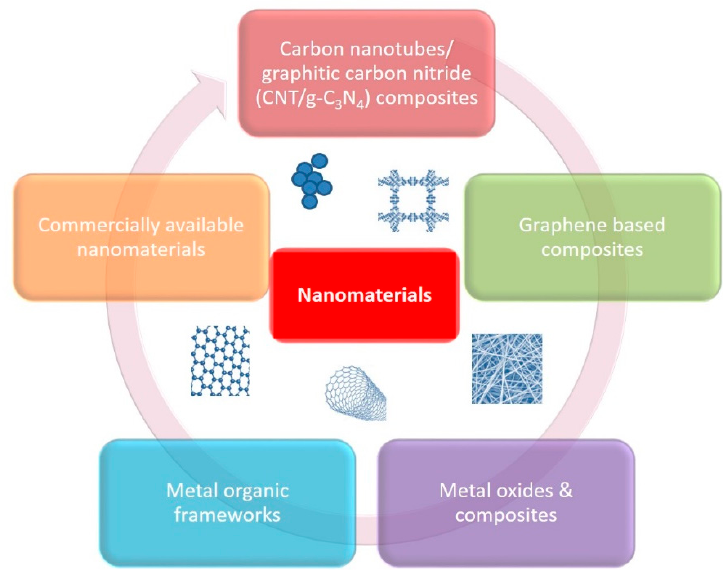
Figure 1. Different categories of nanomaterials presented in the present review (carbon nanotubes /